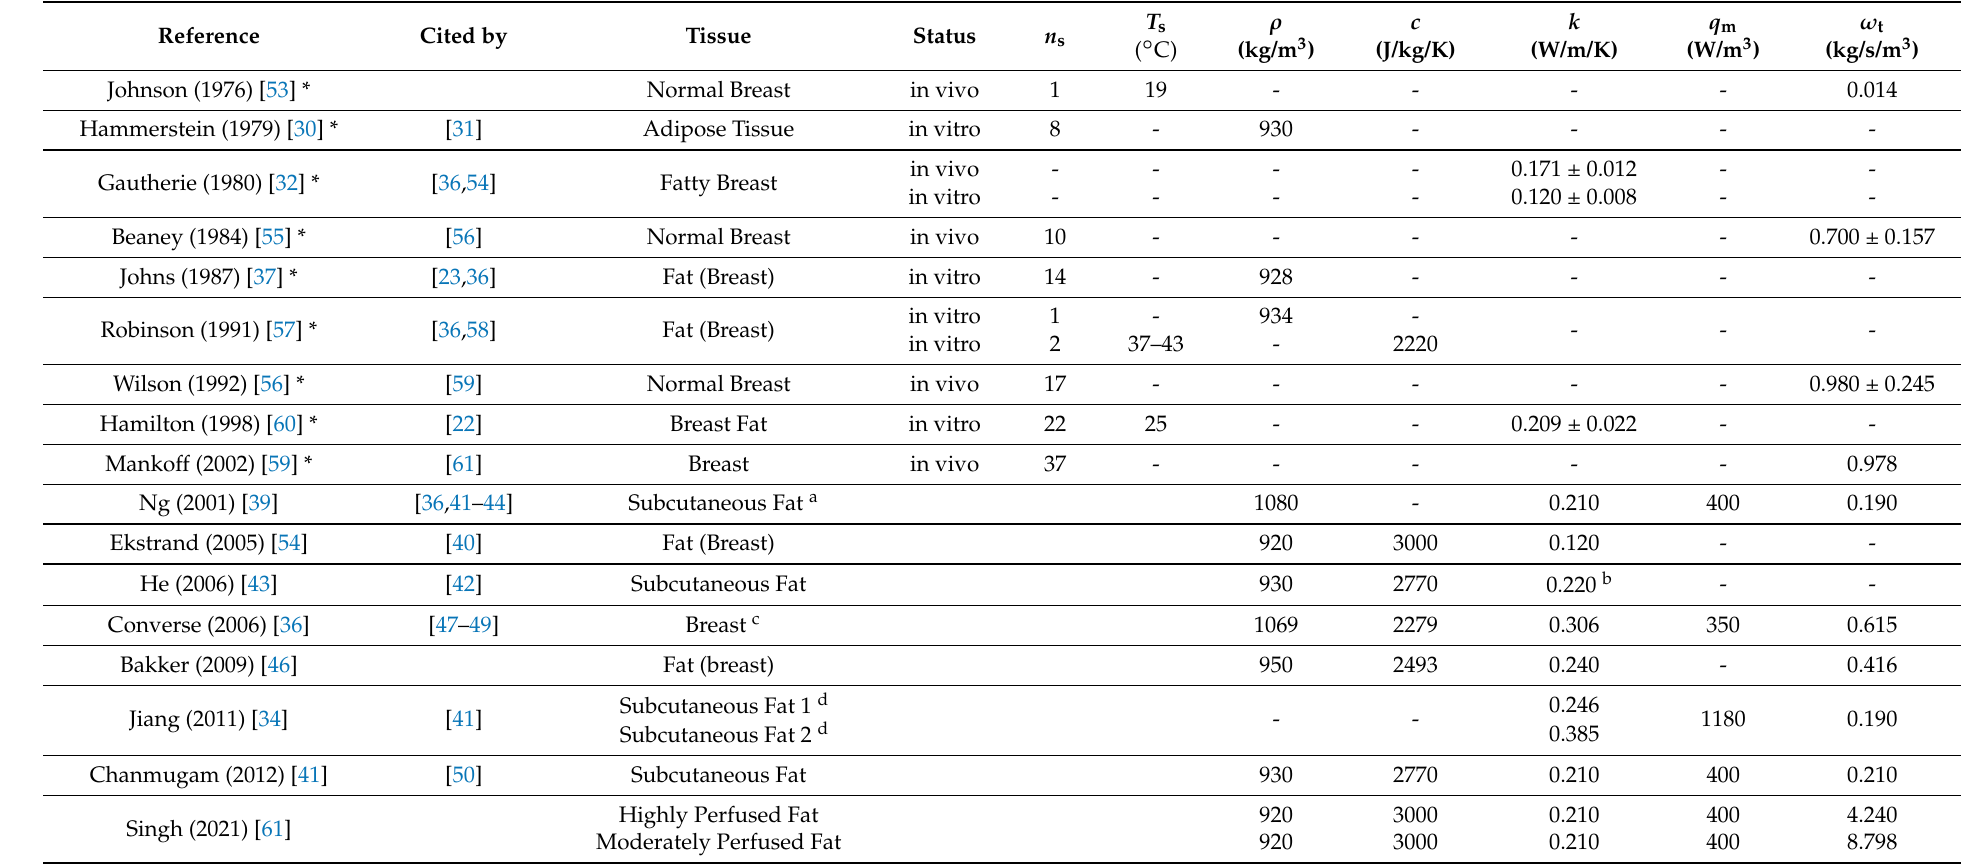
Table 4. The thermal and physiological properties of human fatty breast